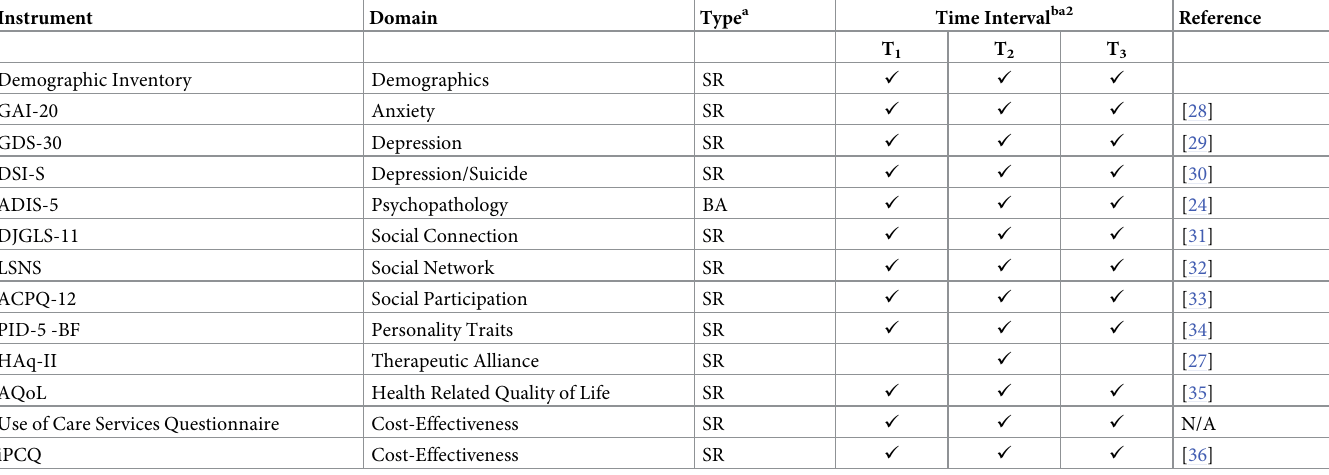
Table 1. Primary and secondary outcome measures by time